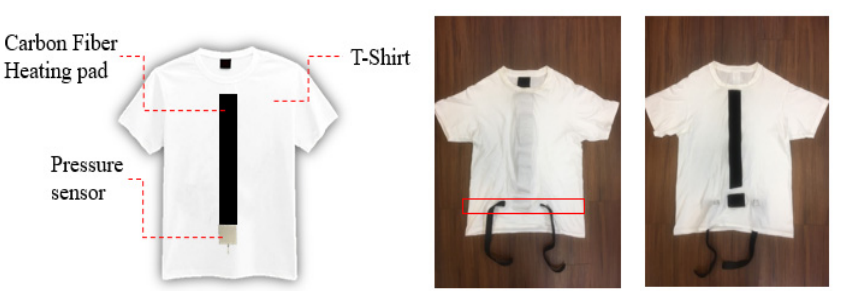
Figure 3. ( Left ) Sketch map of the modified T-shirt. ( Right ) Appearance from both sides of the T-shirt.